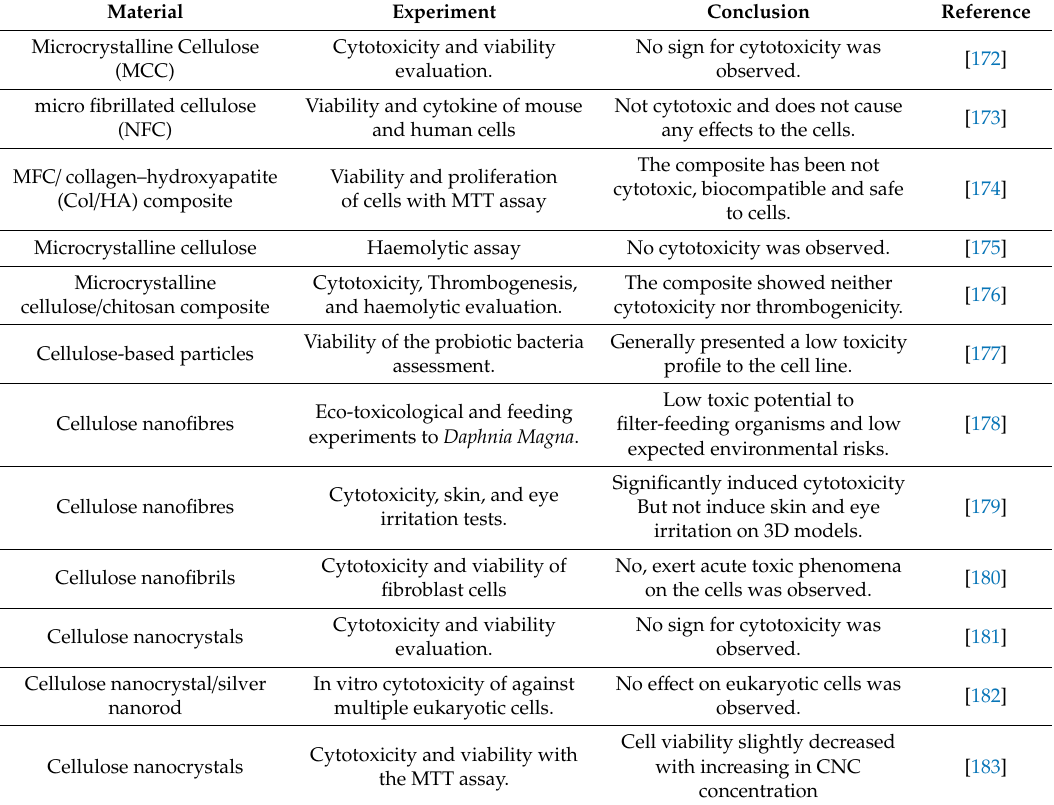
Table 8. Research summary of toxicology analysis of micro- and nanocellulose-based materials.